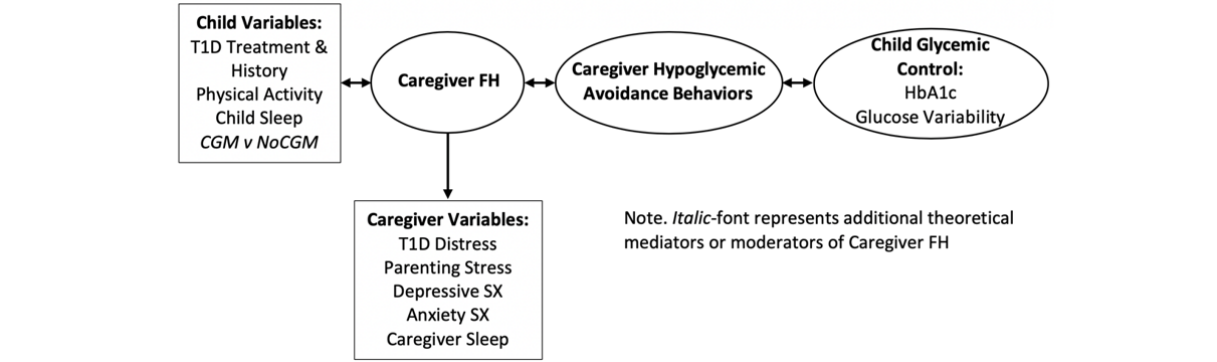
Figure 1. Theoretical model of caregiver fear of hypoglycemia.